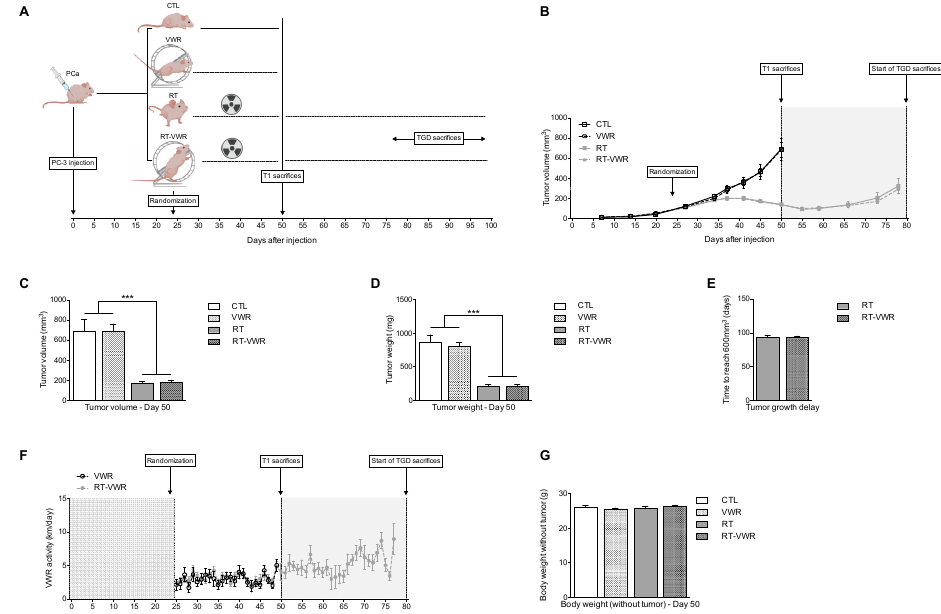
Figure 3. VWR combined with RT does not affect treatment efficiency. ( A ) Experimental design; ( B ) Tumor volume (in mm 3 ) evolution; ( C ) Tumor volume (in mm 3 ) of mice euthanized at T1 (day 50); ( D ) Tumor weight (in mg) of mice euthanized on day 50; ( E ) Number of days for the tumor to reach 600 mm 3 in RT and RT-VWR following RT treatment (tumor growth delay); ( F ) VWR activity over time (in km/day); ( G ) Body weight after tumor was retrieved (in g) at T1 (day 50). Data are represented as means ± SEM. *** p < 0.001.